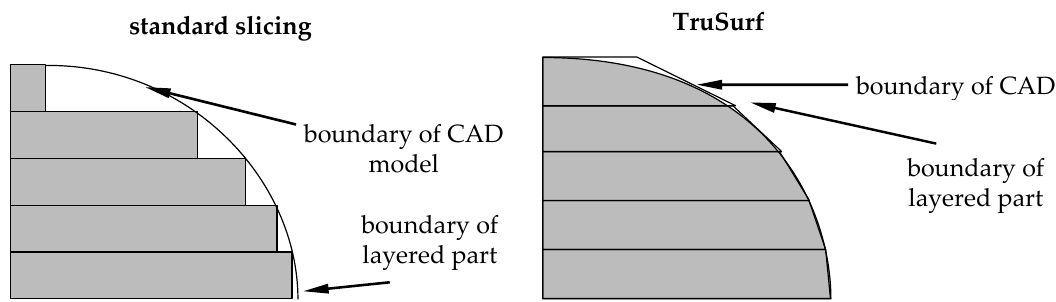
Figure 15. Comparison of the staircase effect between standard slicing and the TruSurf algorithm (based on the work in [52]).